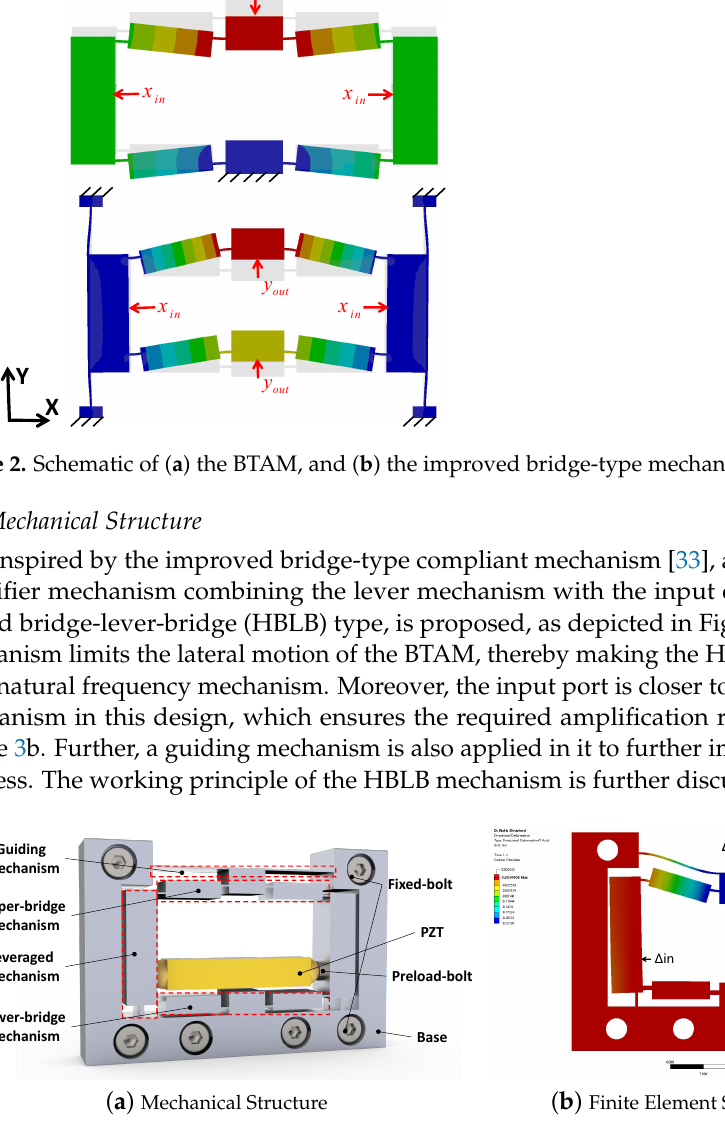
Figure 3. Schematic of the